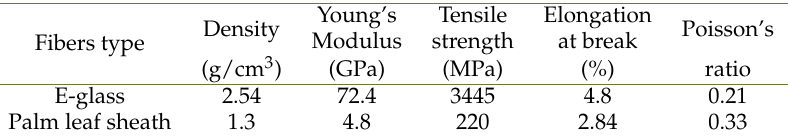
Table 2. Mechanical and physical properties of glass and palm